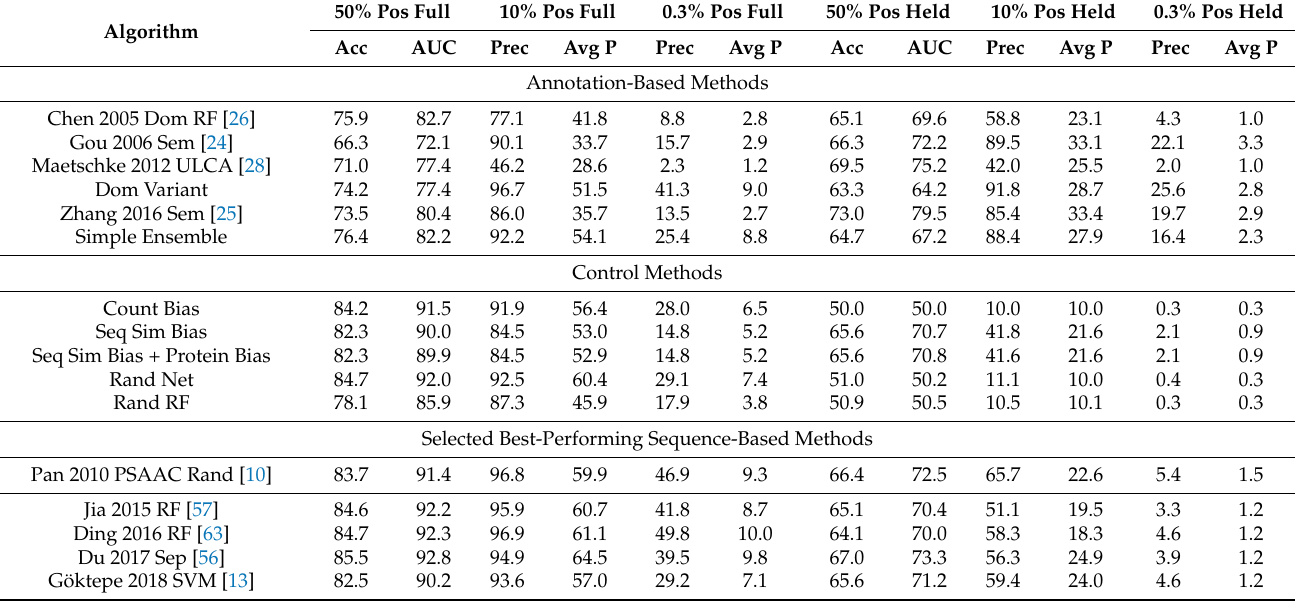
Table 9. Results of non-sequence-based predictors versus control and annotation-based